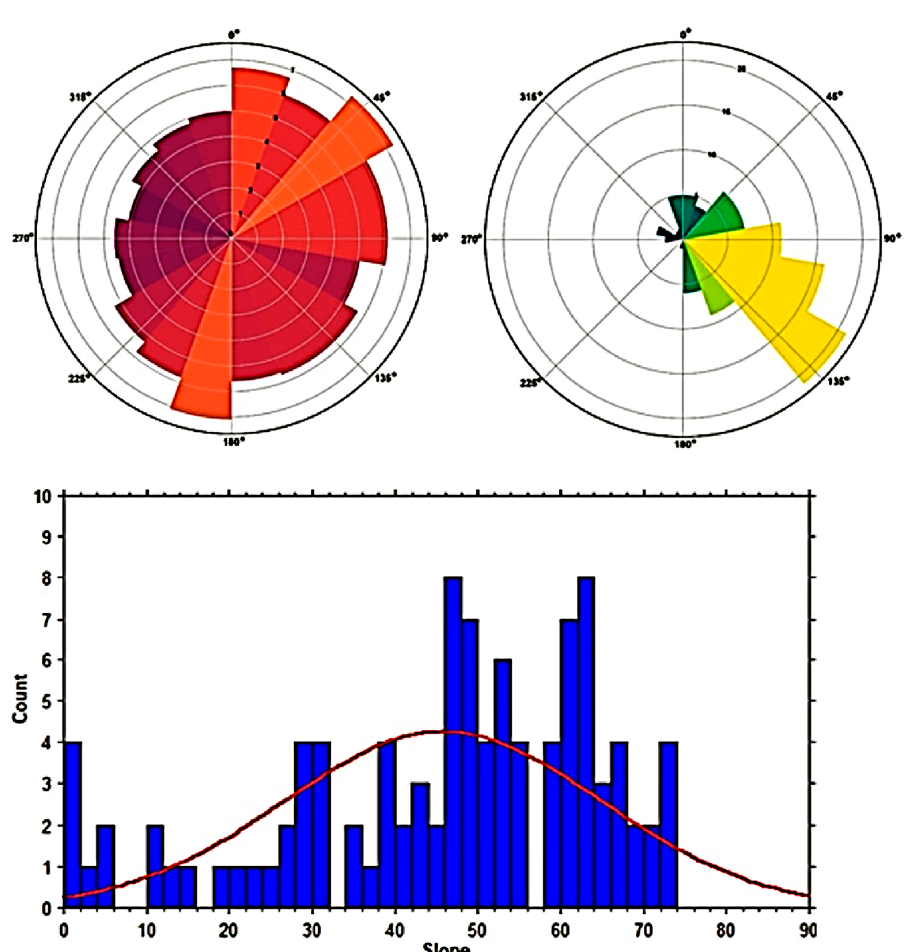
Figure 12. Top left : percent of HS study area in different aspects. Flat (no aspect) surfaces that occur in Owens Valley have been removed. Top right : number of recorded rockfall features in each 20° aspect class for the Owens Lake event. Bottom : distribution of mapped rockfall features by slope of the centroid of the mapped unit.